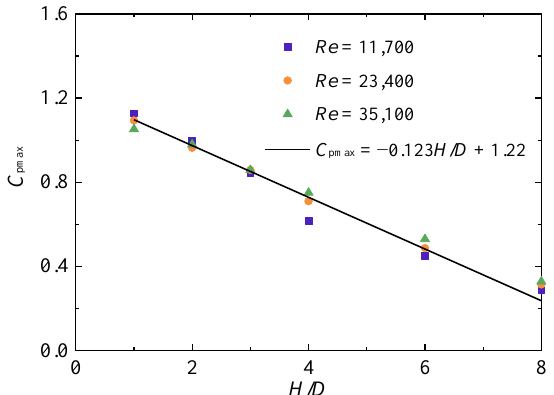
Figure 17. Variation of the maximum pressure coefficient C pmax as a function of H/D .